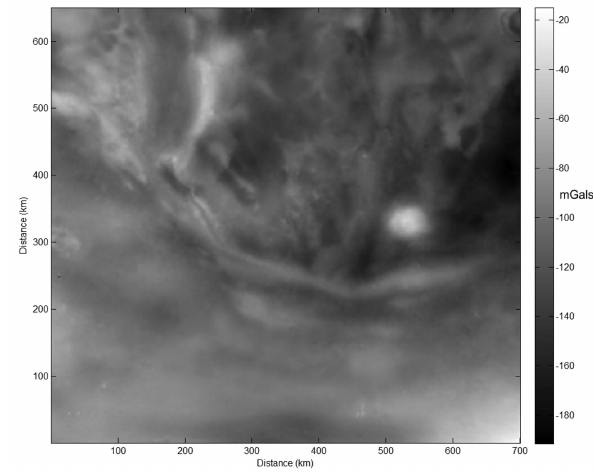
Fig. 1j. Fractal dimension obtained as a function of the number of randomly located buried sphere sources, at a depth of 5m. The mass of each sphere was generated randomly between 0 and 10 11 kg. Be- cause the fractal dimension depended on the locations of the spheres and these were calculated randomly, the experiment was repeated five times and the mean value and the standard deviation deter- mined.